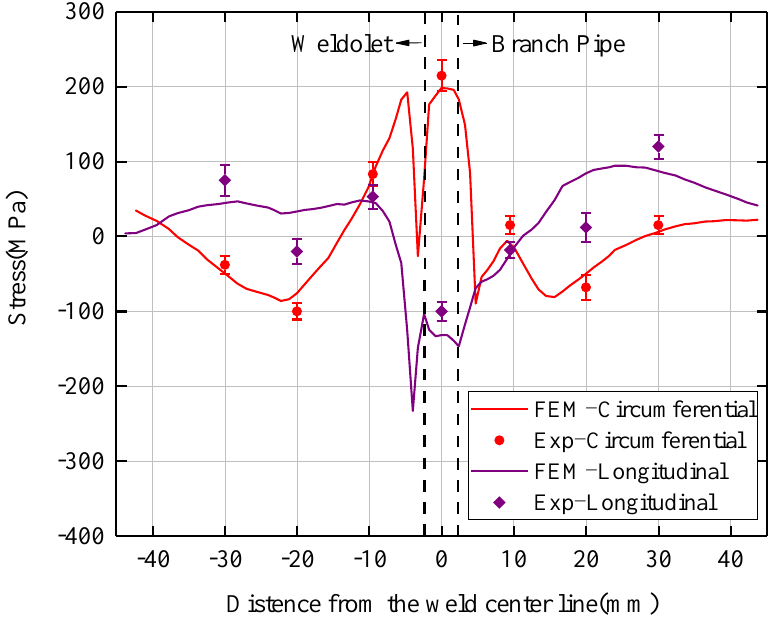
Figure 10. Comparison of the residual stress obtained from the experiment and the finite element calculation.